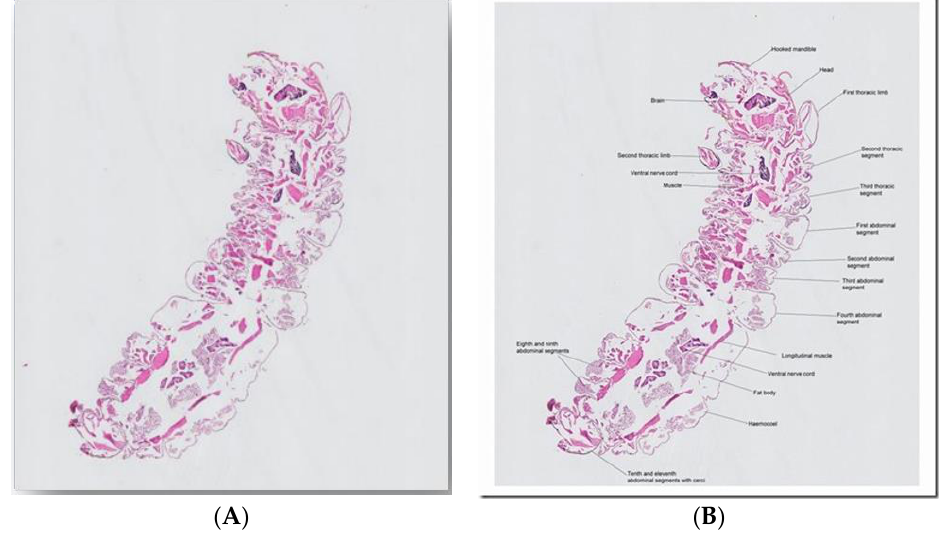
Figure 4. ( A ) Picture of histological section of ‘ worm ’ sent to the e-Diagnosis team. ( B ) The same picture that was labelled and sent back to the team by Professor Anderson, showing various morphological features that are consistent with an endopterygota larva.